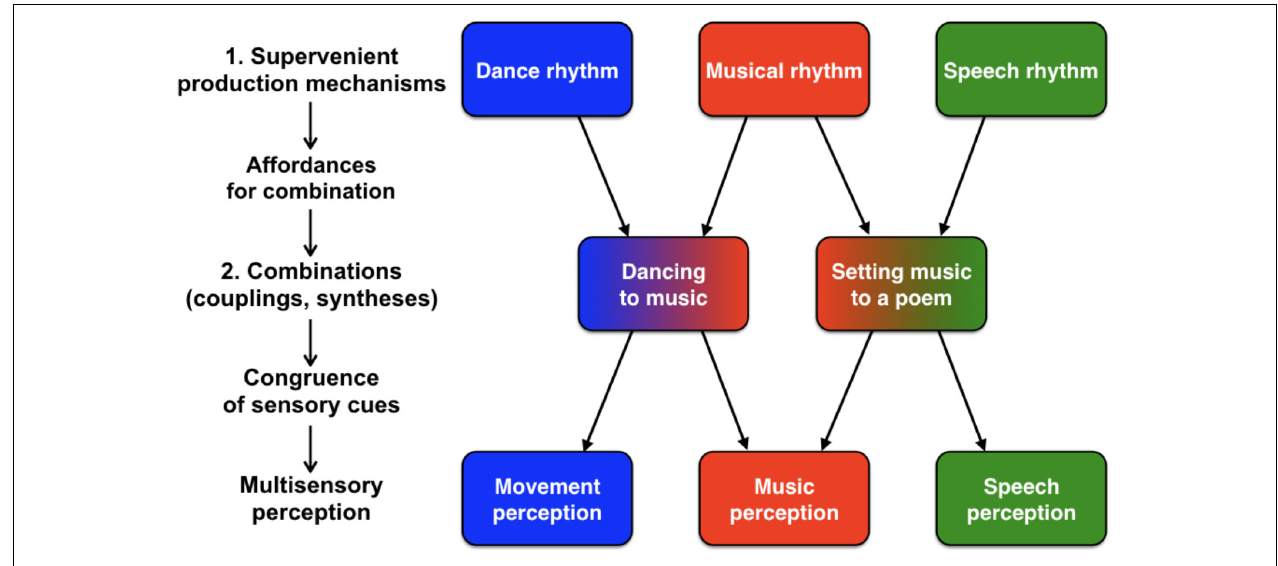
FIGURE 2 | How artforms can combine. Shared production mechanisms between two or more artforms create affordances for combination, permitting a natural coupling between them in time and/or space. The combination of elements from these syntheses activates sensory processes for multiple systems in parallel. This often works out at the production level such that the elements from each artform are congruent and mutually reinforcing.